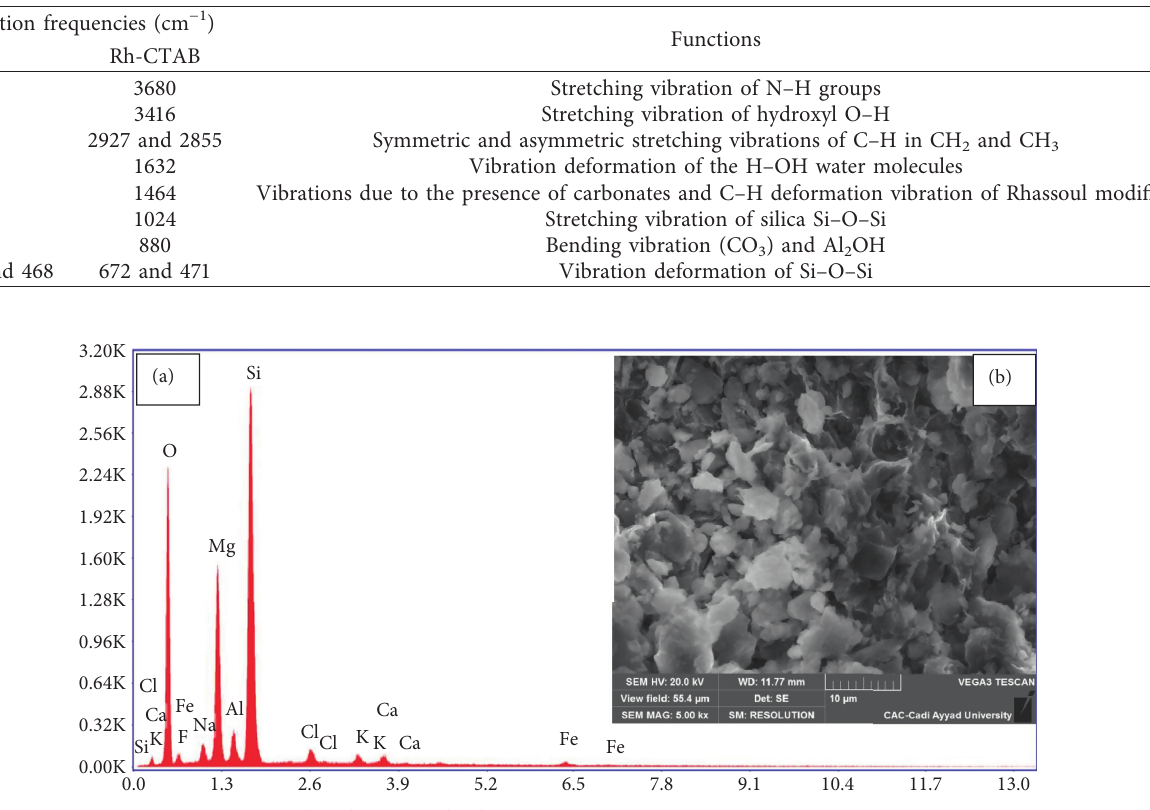
Figure 2: Infrared spectra of the Rh-P (a) and Rh-CTAB (b). Table 2: Vibration bands of the Rh-P and Rh-CTAB.